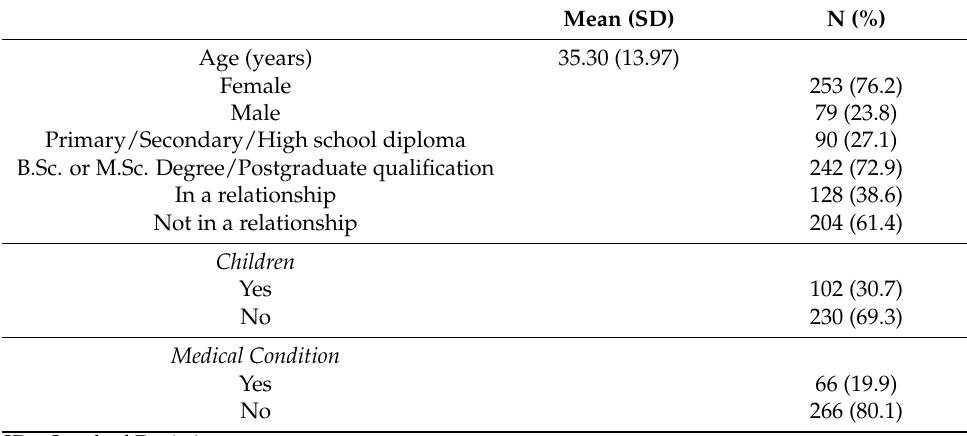
Table 1. Sociodemographic data of the total sample (N = 332).